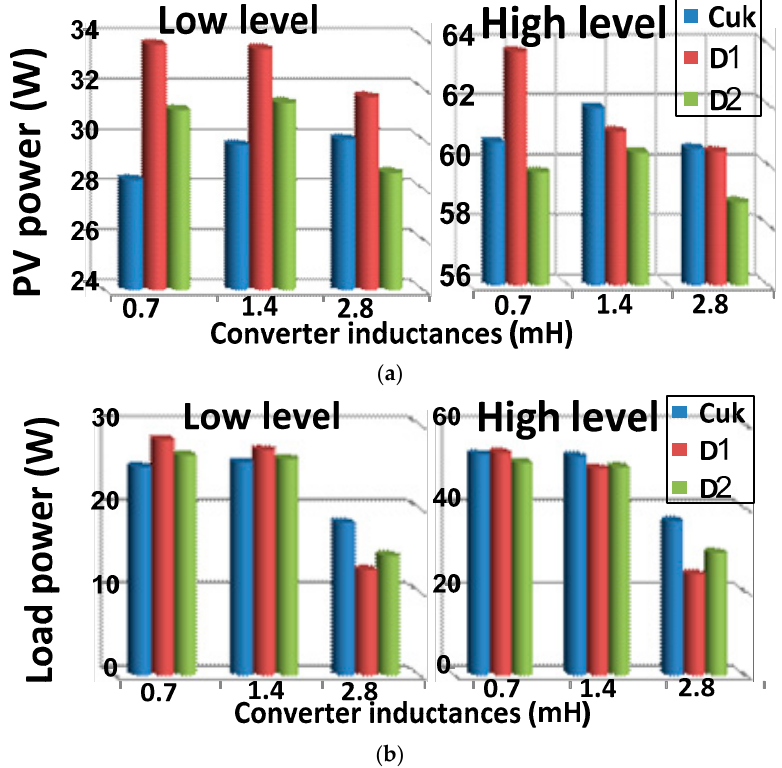
Figure 10. Experimental results analysis: ( a ) PV power; ( b ) average load power.